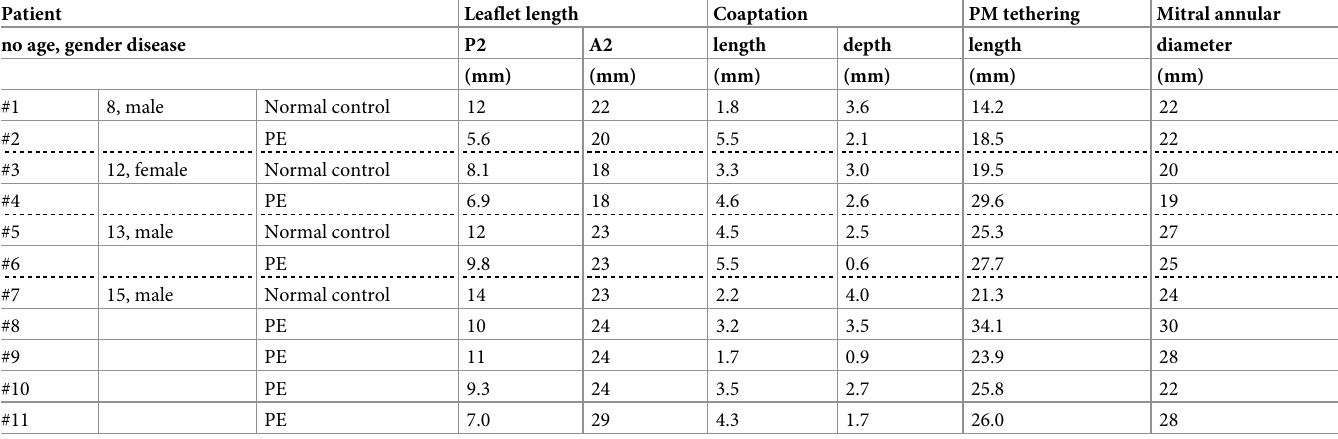
PE indicates pectus excavatum. PM indicates papillary